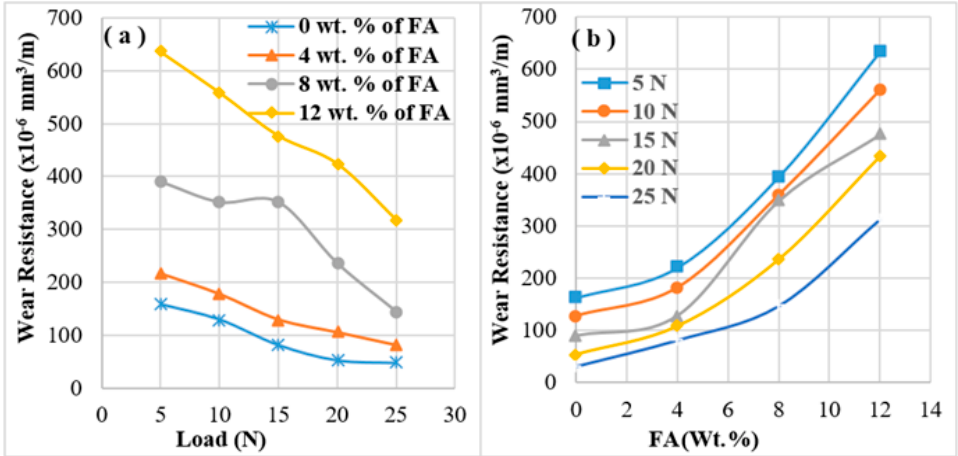
Figure 6. Wear resistance of AA 6061 alloy-based MMCs as a function of ( a ) normal load applied; ( b ) wt.% fly ash [53].